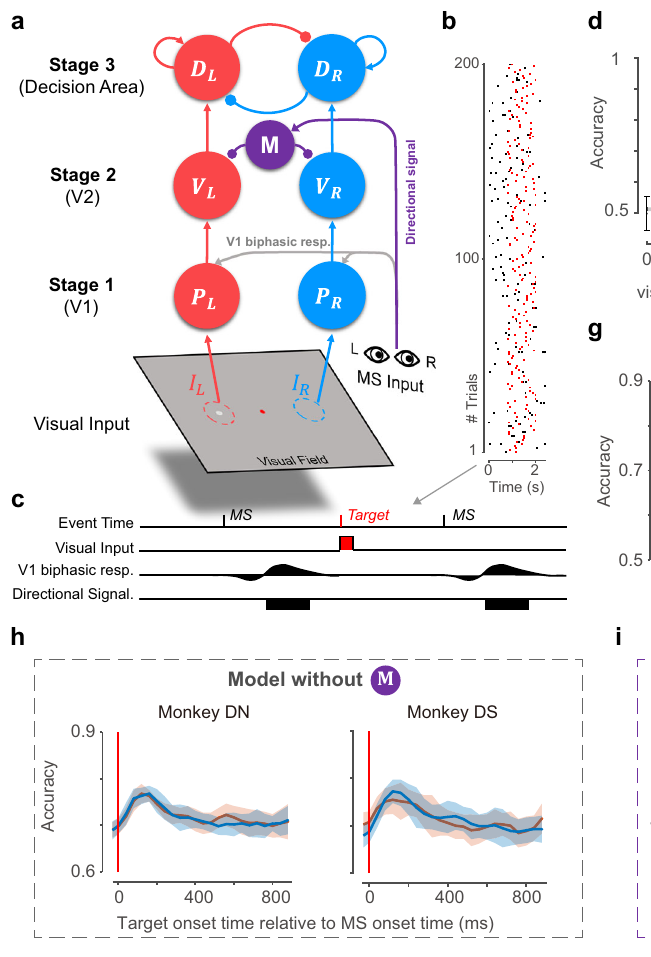
Fig. 6 | A dynamic model links neurophysiology and behavior. a Structure illustrationofthedynamicrecurrentnetworkcomposedoftwovisualstages( P and V ), a mutually inhibited decisionstage,and two modulationcomponents (biphasic kerneland M ).The fi rststage( P )wasstimulatedbya20-mscurrentwhentherewas a visual target in the RF. Each microsaccade triggered a biphasic modulation on both components in stage 1 ( P ) and triggered a directional signal to M . M only suppressesthesecondstage( V )withRFintheoppositedirectionofmicrosaccades. b The onset time of microsaccades (black dots) and targets (red dots) in example trials from the 2AFC detection task. Targets appeared randomly within 0.8~2s in each trial. c Model input from a time period in one example trial, including visual input to layer 1, biphasic input tostage 1,and directionalsignalinput to M . d Mean accuracy (±s.d.) across simulations ( n =30, each simulation was composed of one repetition of all possible target locations and target onset times) for each level of visualinputstrengthinarbitraryunits(arb.units). e Modelresponse(mean±s.d.)in stage2( V )aroundthemicrosaccade,whichshowedsimilardirectionmodulationto